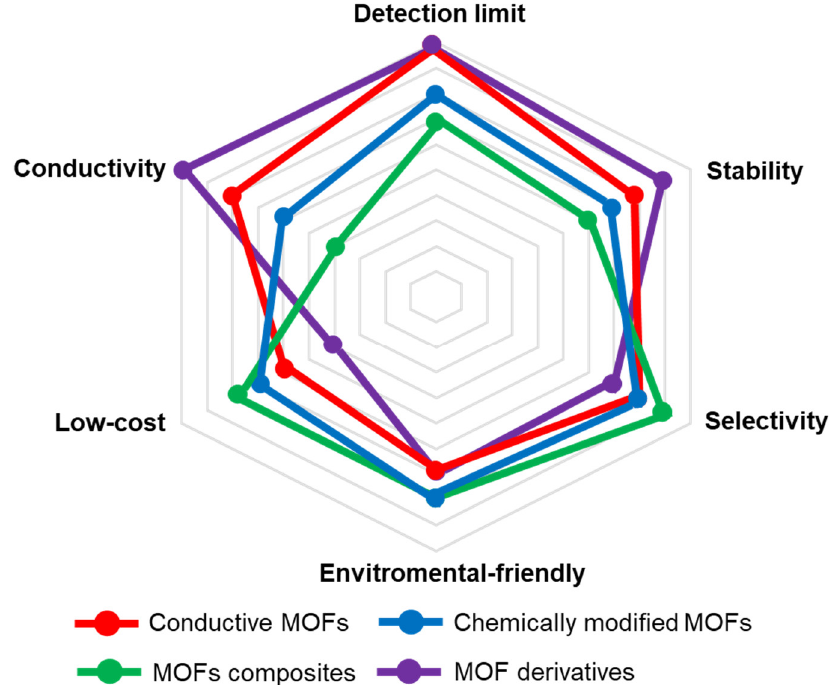
Figure 7. The pros and cons (such as detection limit, conductivity, stability, selectivity, low-cost and environmental-friendly) of the introduced catalysts for H 2 O 2 electrochemical sensor (The outside is better, the inside is worse).